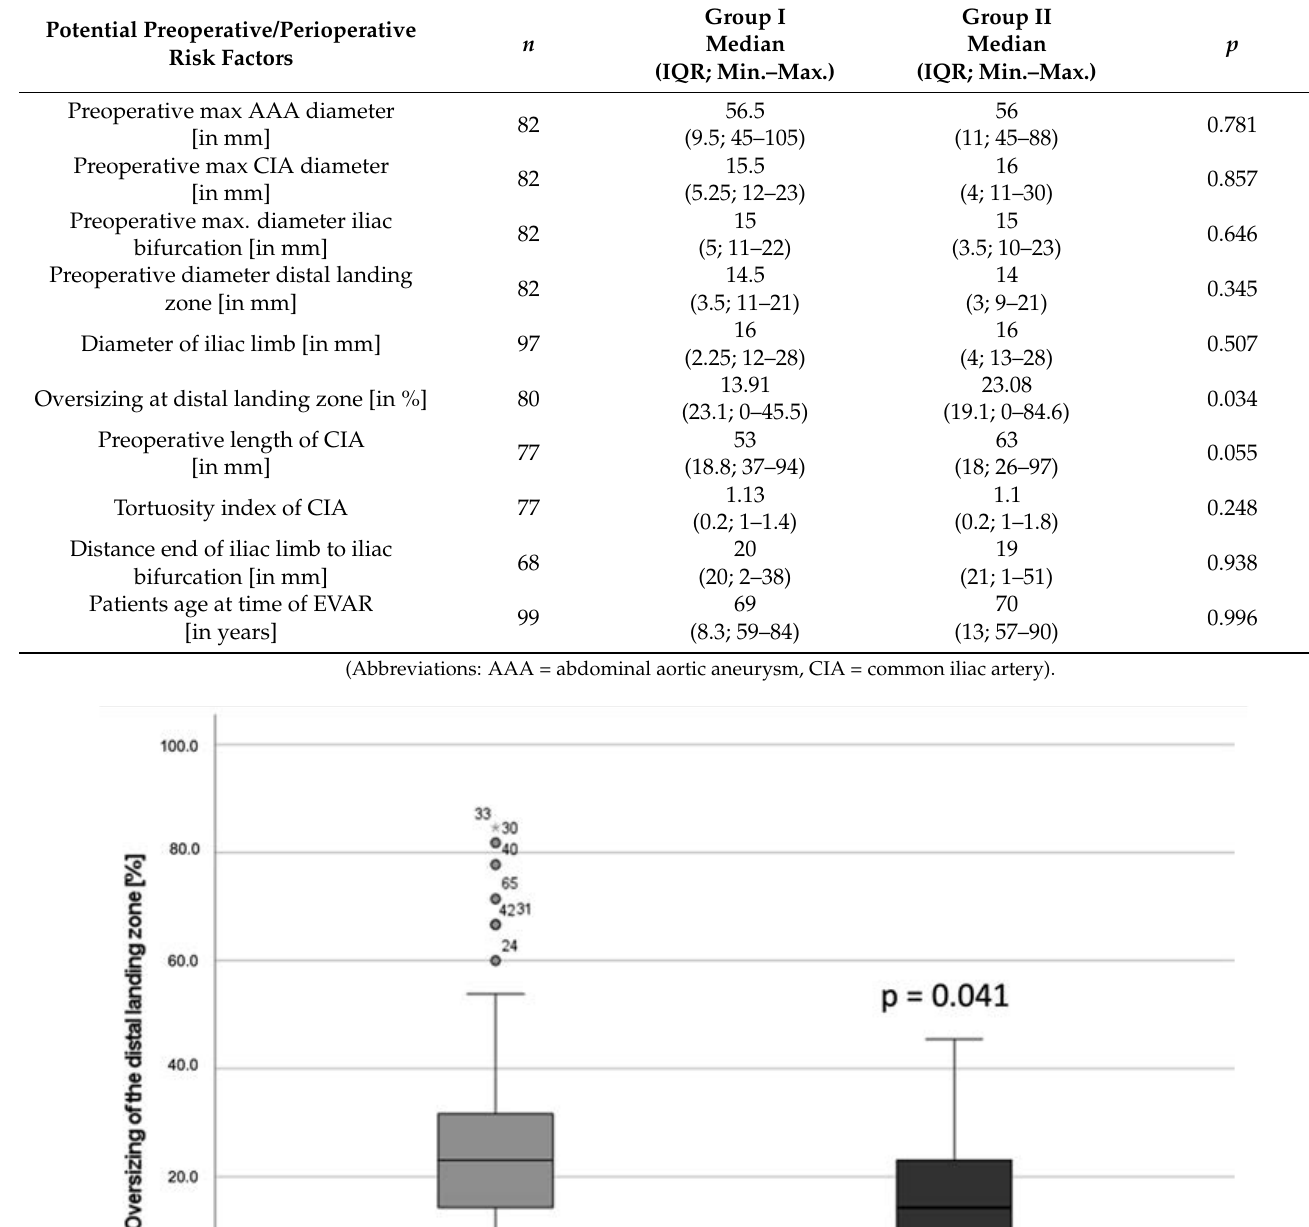
Table 2. Potential risk factors for detachment.